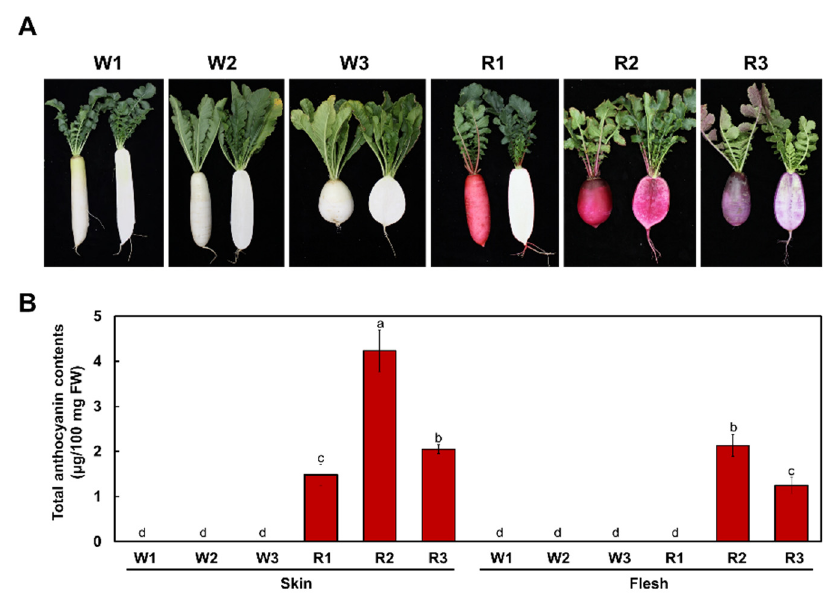
Figure 1. Phenotypes and anthocyanin contents of the six radish cultivars used in this study. ( A ) Representative photographs of white- and red-taproot radishes at the mature stage, with whole taproots on the left and taproots sectioned to show flesh color on the right of each image. ( B ) Anthocyanin levels in white and red taproot radishes. Results are mean values ± SD from three independent biological replicates. Different letters above the bars indicate significantly different values ( p < 0.0001, one-way ANOVA followed by Duncan’s multiple range test).